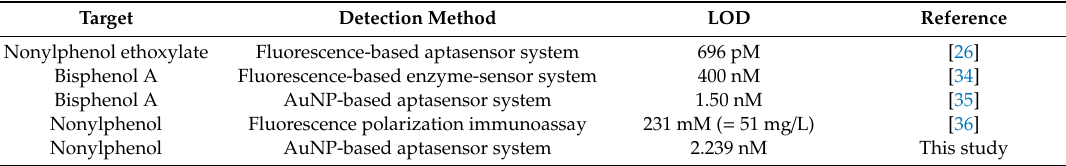
Table 1. Detection methods for EDCs from previous